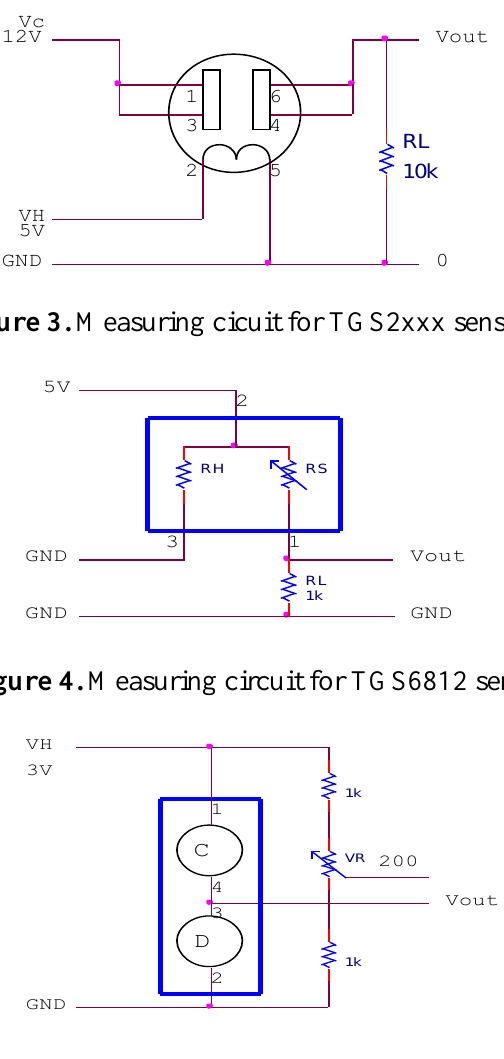
Figure 2. Measuring circuit for TGS8xx sensor.